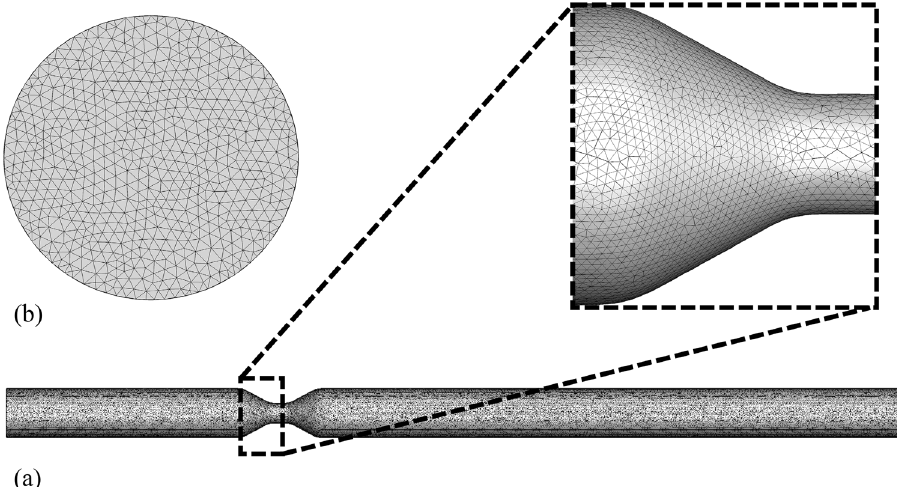
Fig. 2 a The computational mesh of the considered model, contraction area, b meshing zoom in for the vessel